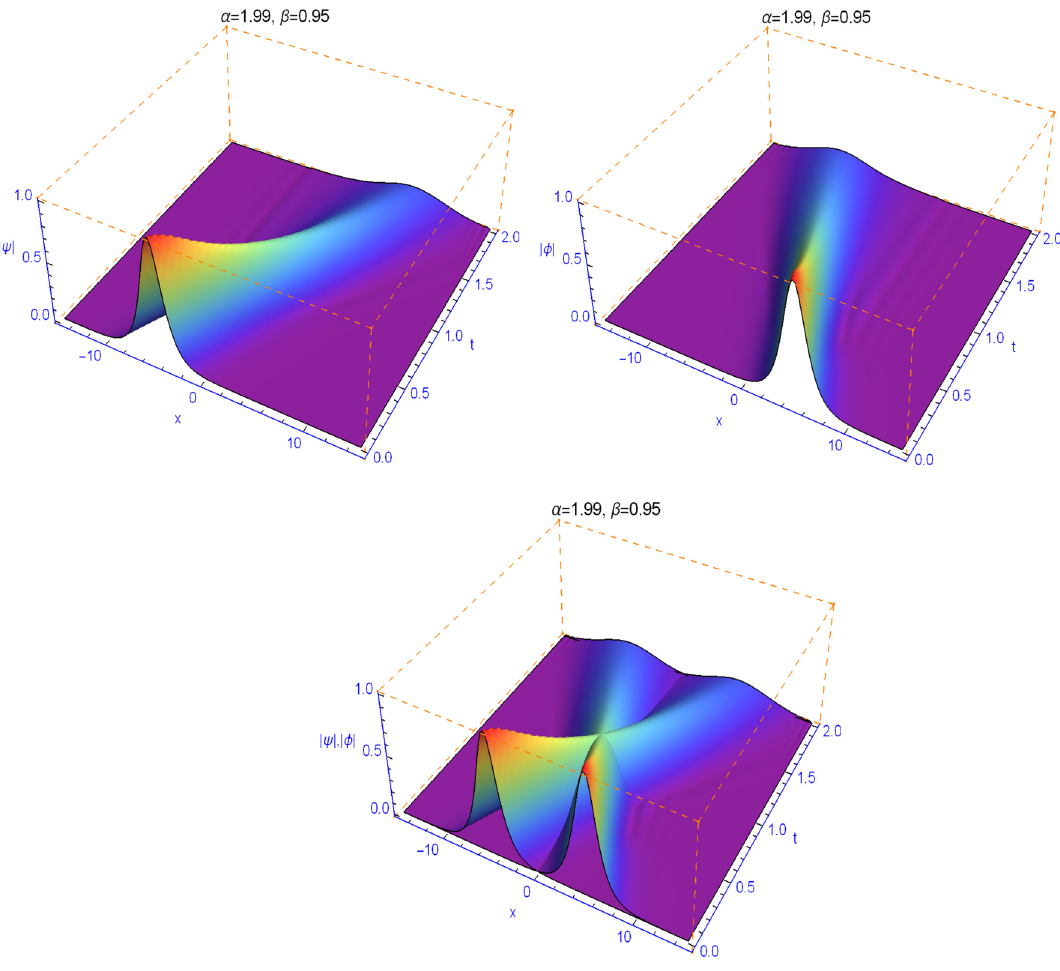
Figure 3. Plots of model (36) for β = 0.95 and α = 1.99